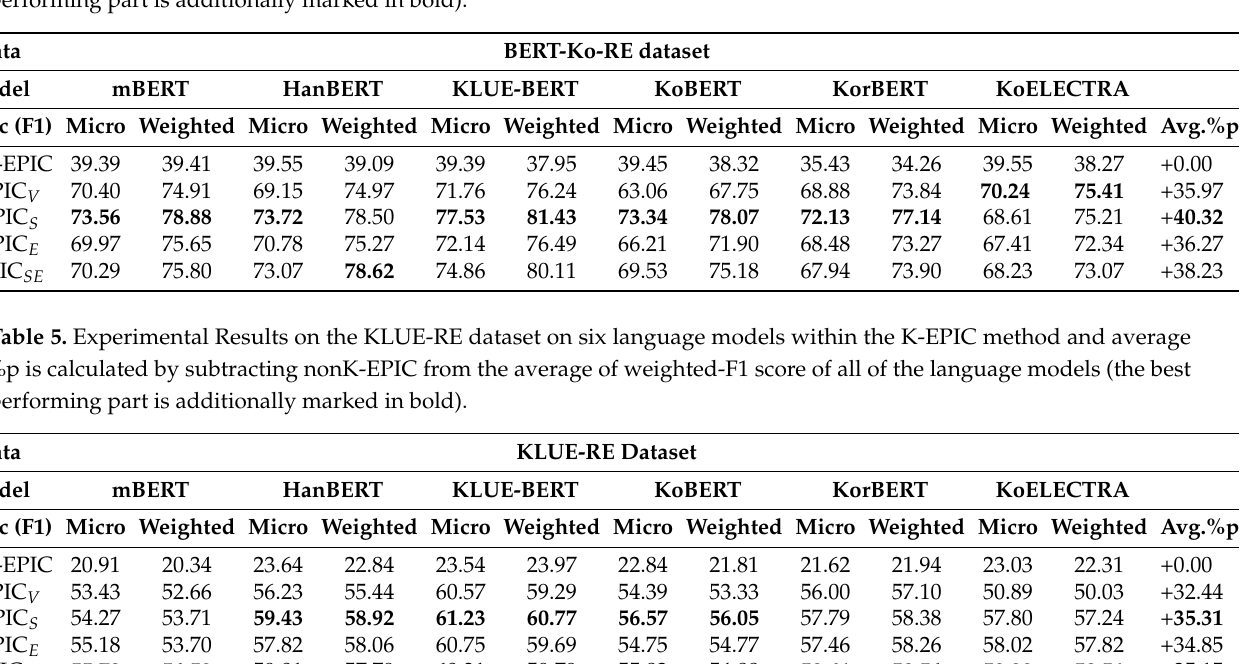
Table 4. Experimental results on the BERT-Ko-RE dataset on six language models within the K-EPIC method and average %p is calculated by subtracting nonK-EPIC from the average of weighted-F1 score of all of the language models (the best performing part is additionally marked in bold).